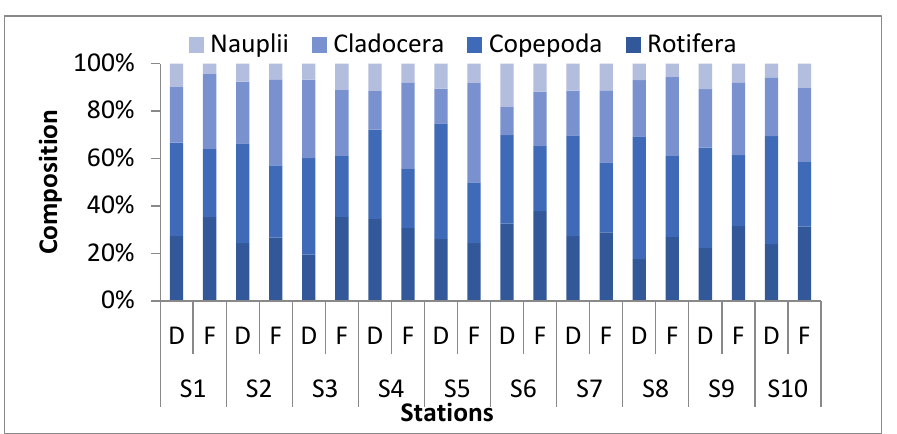
Figure 2. Composition (%) of zooplankton classes in two seasons at different stations (D = December, F = February).